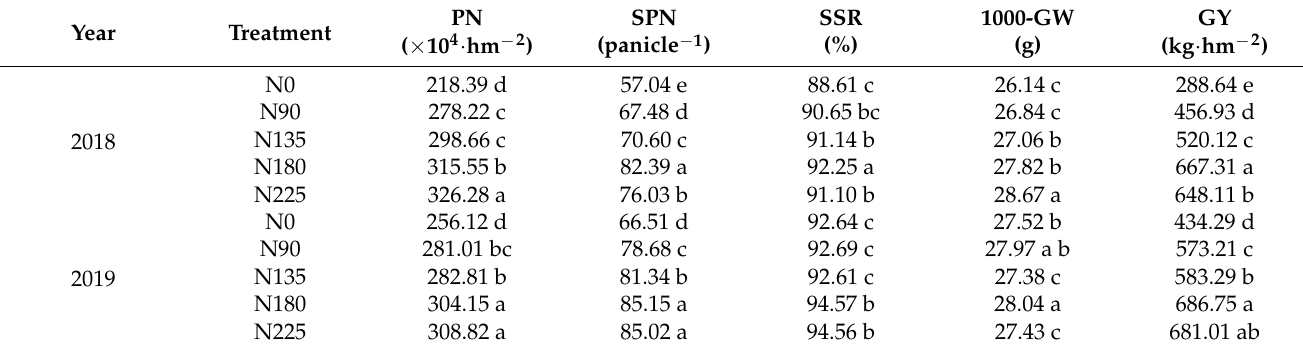
Table 2. Effects of different nitrogen application amount on yield and its components of